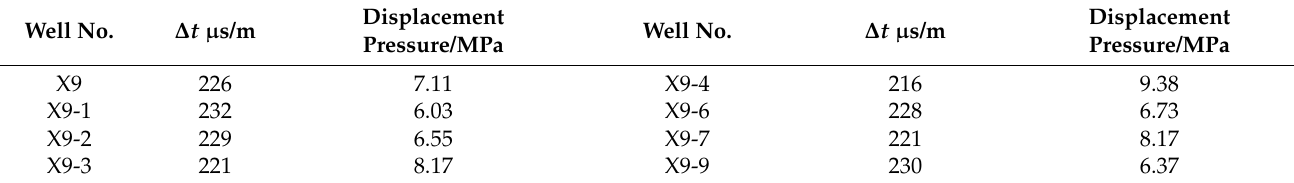
Table 12. Calculated results of displacement pressure of in each well of X9 area.